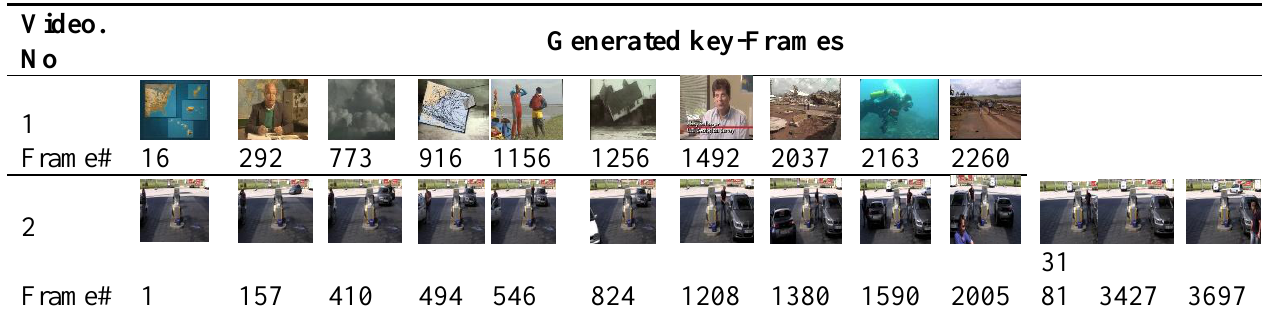
Table 4. Key-Frames that are extracted at VPH.